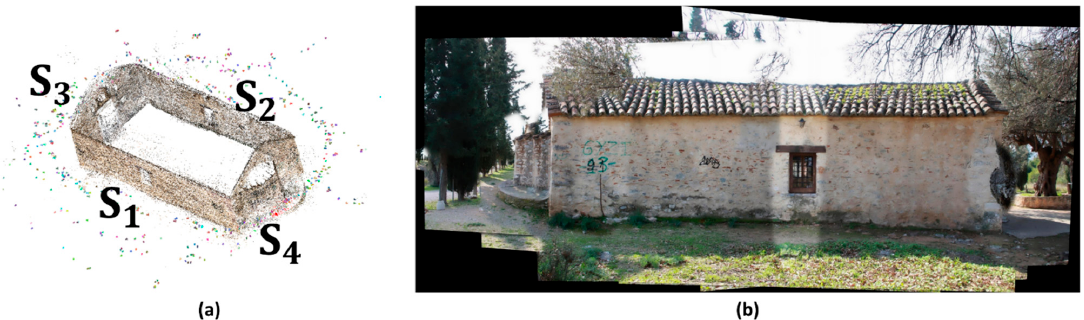
Figure 9. Steps in the orthophoto generation process for the Church of Agios Nikolaos: ( a ) the point cloud generated and its four major façade planes; and ( b ) a representative orthophoto generated from S 1